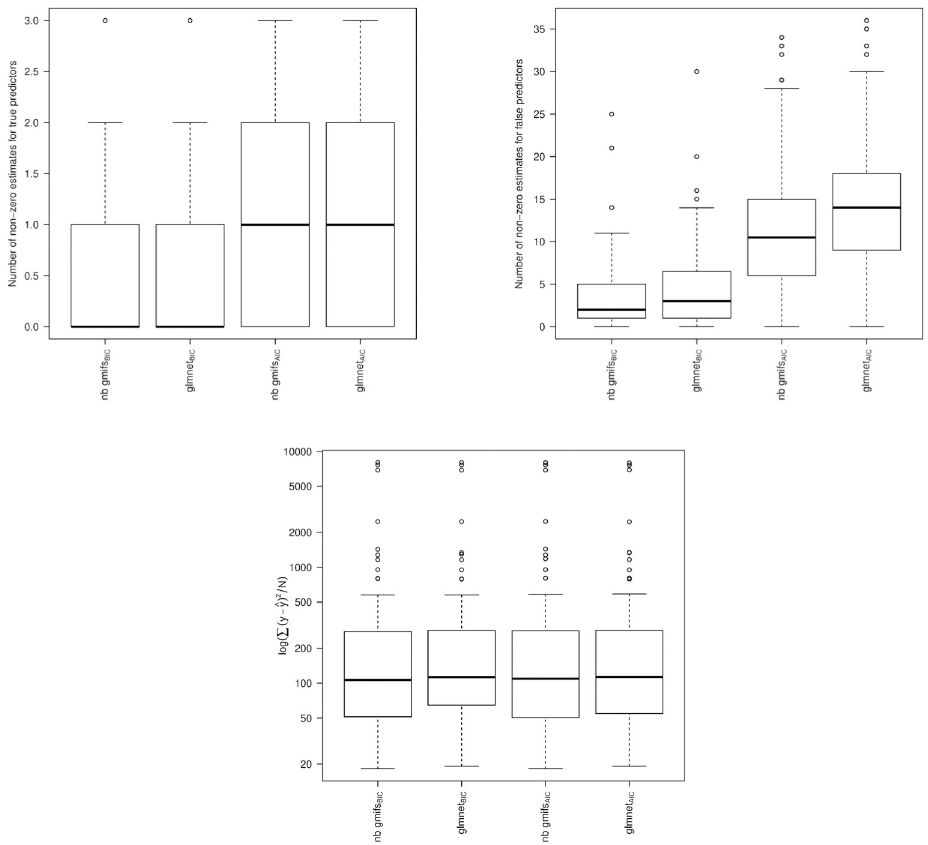
Fig 6. Results from large simulation study of P = 5, 000 correlated predictors and N = 50 observations. A: Number of true predictors that had a non-zero coefficient estimate (Oracle = 5). B: Number of false predictors that had a non- zero coefficient estimate (Oracle = 4,995). C: Prediction error for each modeling method and selection criteria.